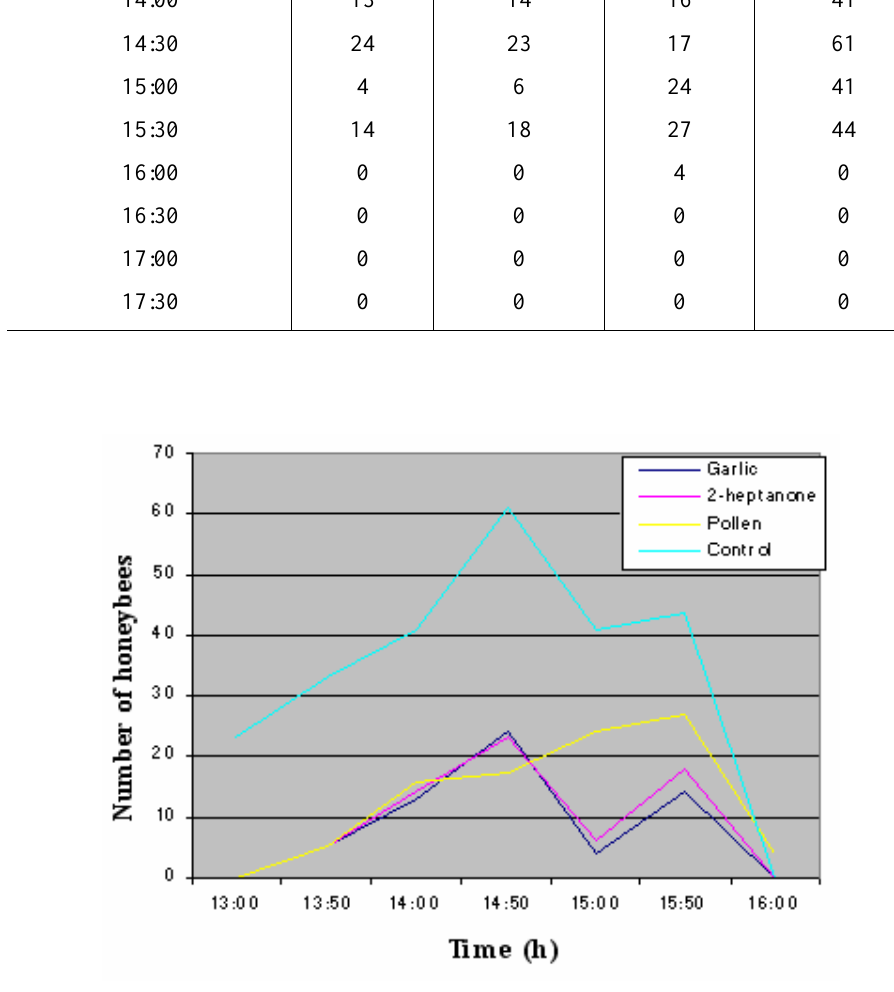
Figure 2 . Average number of honeybees in passion fruit-flowers in the 4 treatments from 10:00 to 17:30